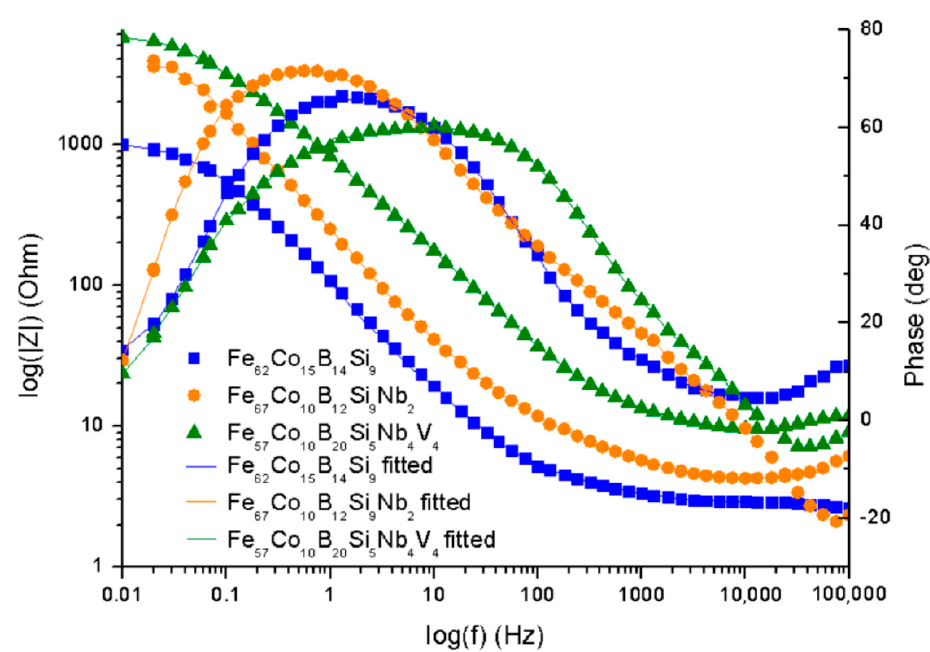
Figure 7. EIS for specimens in 0.5 M NaCl—Nyquist plots.